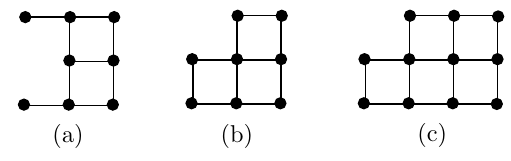
Figure 7: The graphs H